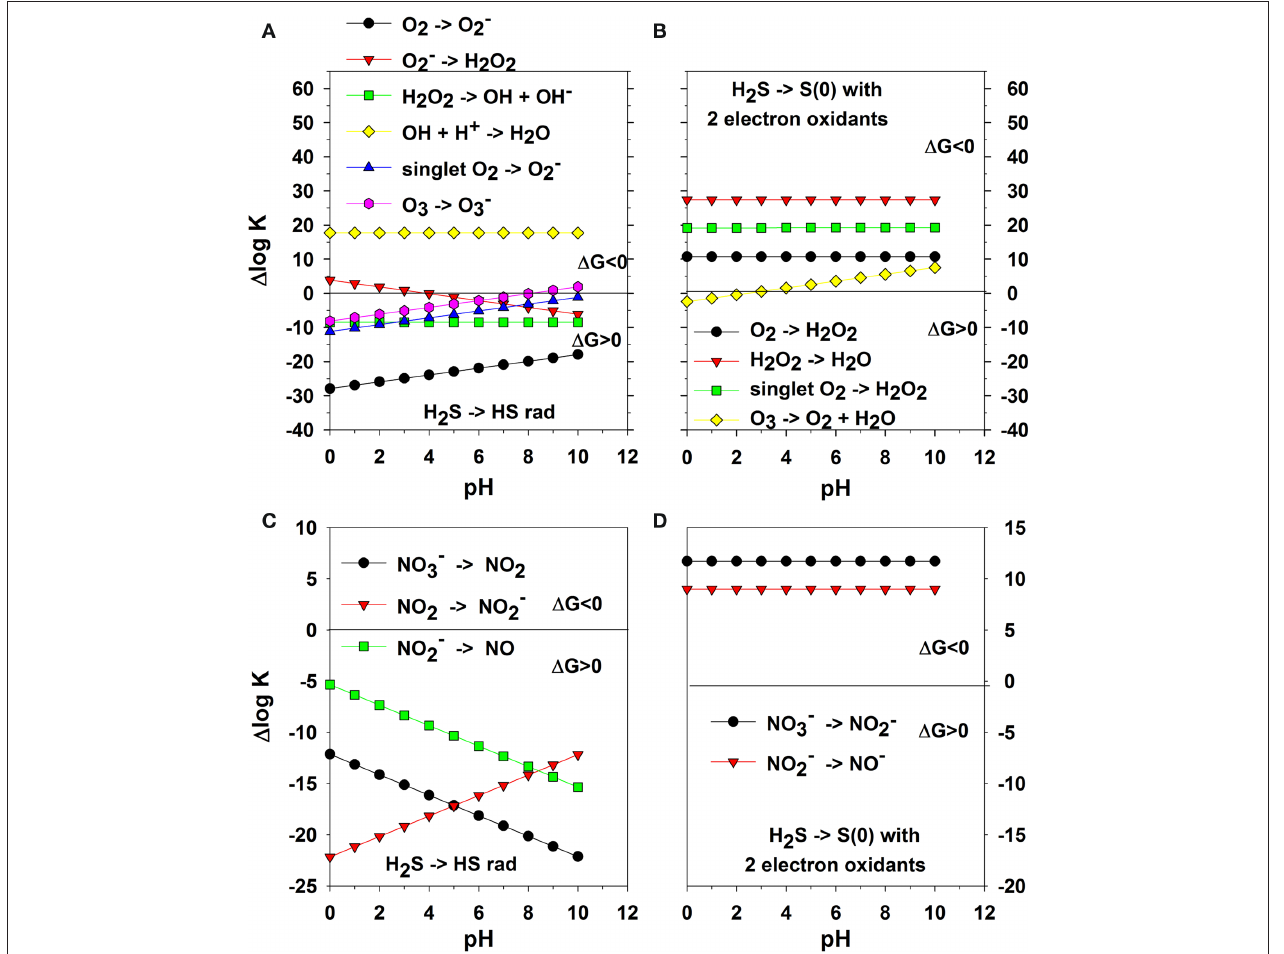
Figure 1 | One-electron transfer reactions of H S with oxygen species; transfer reactions of oxygen species coupled with Eq. 5. (B) two-electron 2 the + ∆ log K on the y -axis indicates a favorable complete reaction and transfer reactions of oxygen species coupled with Eq. 8. (C) one-electron transfer reactions of oxidized nitrogen species coupled with Eq. 5. − ∆ log K indicates an unfavorable reaction as ∆ g o = − rT lnK = − 2.303 rT log K. HS − reactions are not included but are similar in reactivity (note (D) two-electron transfer reactions of oxidized nitrogen species coupled pK of H S ∼ 7 and depends on salinity and temperature). (A) one-electron with 2